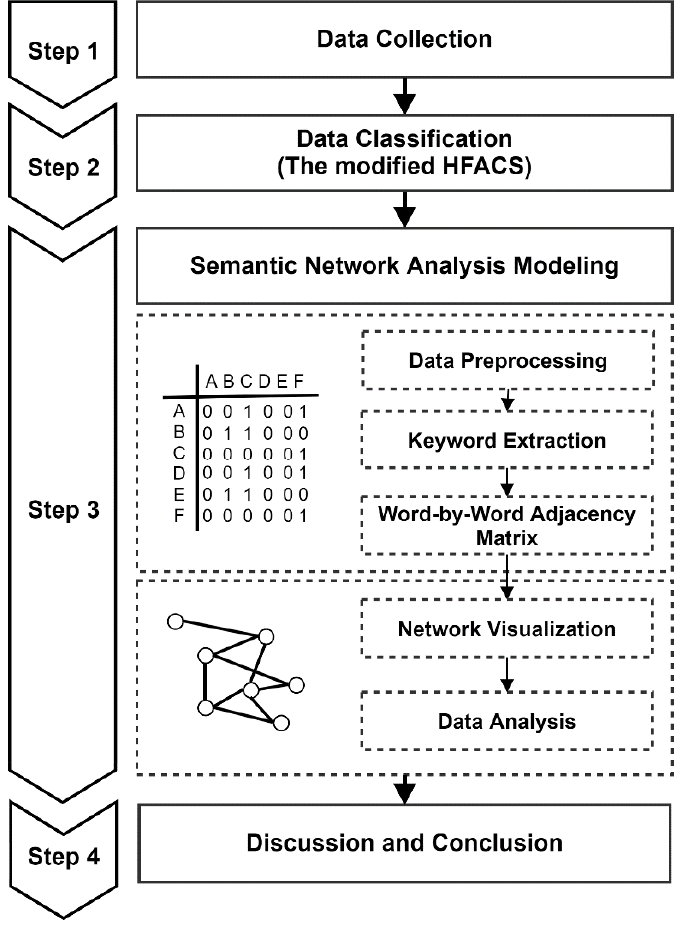
Figure 1. Research